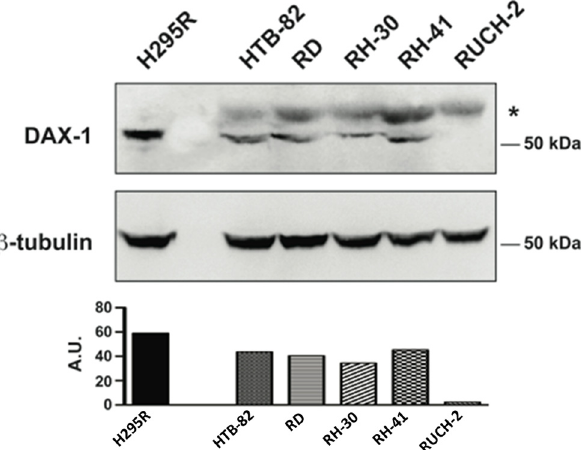
Fig 6. Western Blot showing DAX-1 expression in 4 out of five cell lines. The asterisk indicates a non- specific band present only in RMS cell lines. The histogram shows the relative amounts of DAX-1 expression in each cell line. The densitometry was calculated (ImageJ software) as the ratio between the intensities of the bands corresponding to DAX-1 for each cell line and the corresponding bands of β -tubulin multiplied by 100 and expressed in arbitrary units